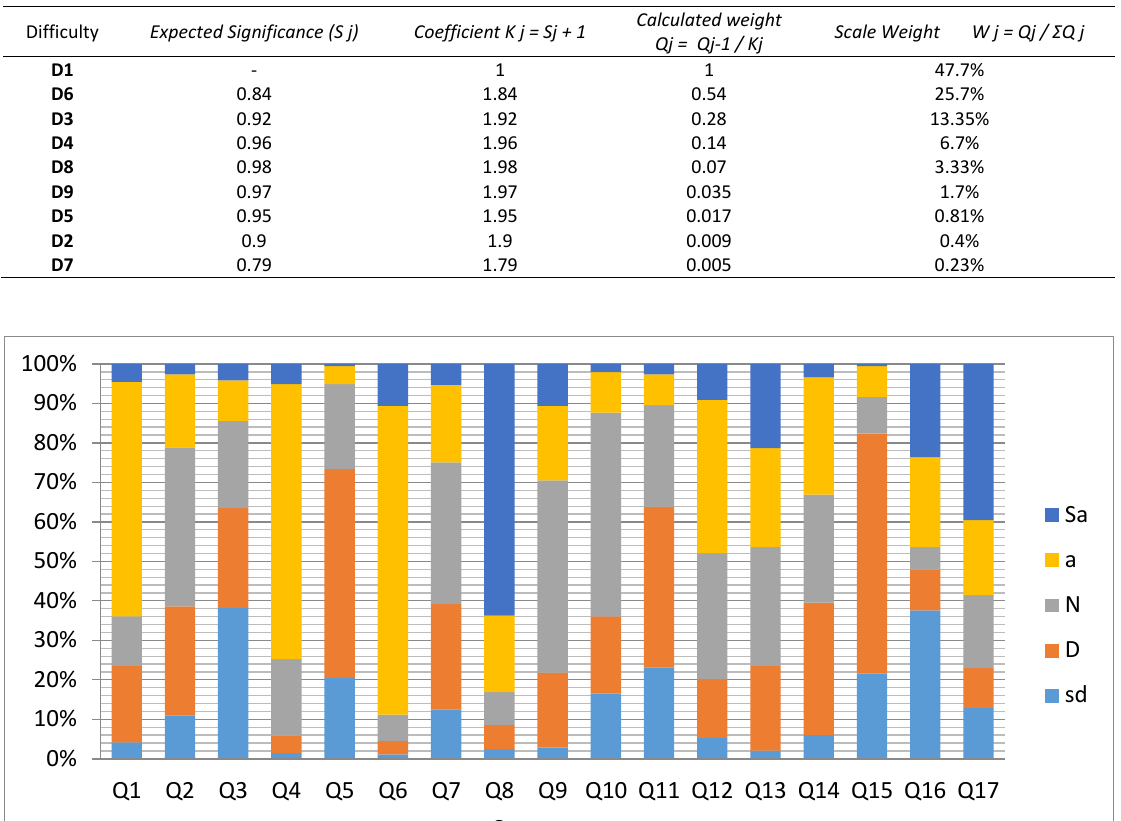
Table 4: SWARA weight calculation